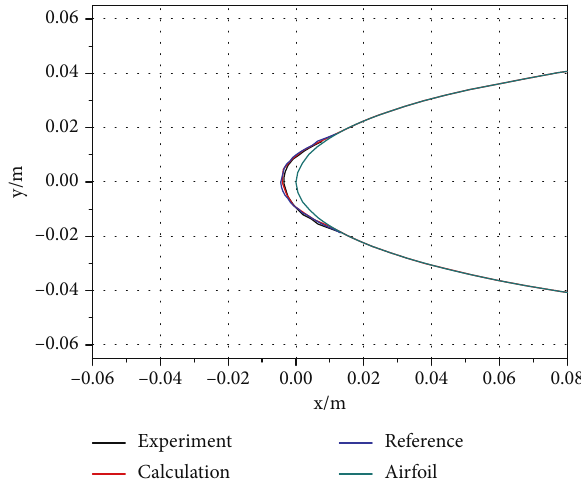
Figure 4: Comparison of ice shapes for condition (3).